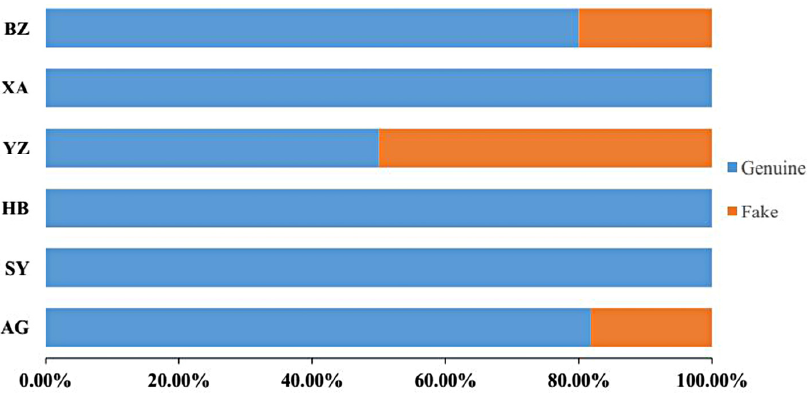
Figure 4. The adulterant rate observed for 38 P. kadsura samples.